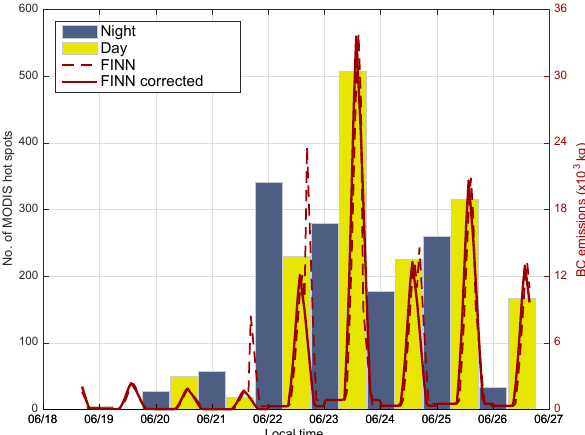
Figure 1. MODIS fire hotspot detections, excluding those with con- fidence less than or equal to 20% and double detections within 1.2km of each other (left axis) and domain-wide FINNv1.0 BB emissions during the ARCTAS-CARB campaign, with and without fixes described in Sect. 2.2 (right